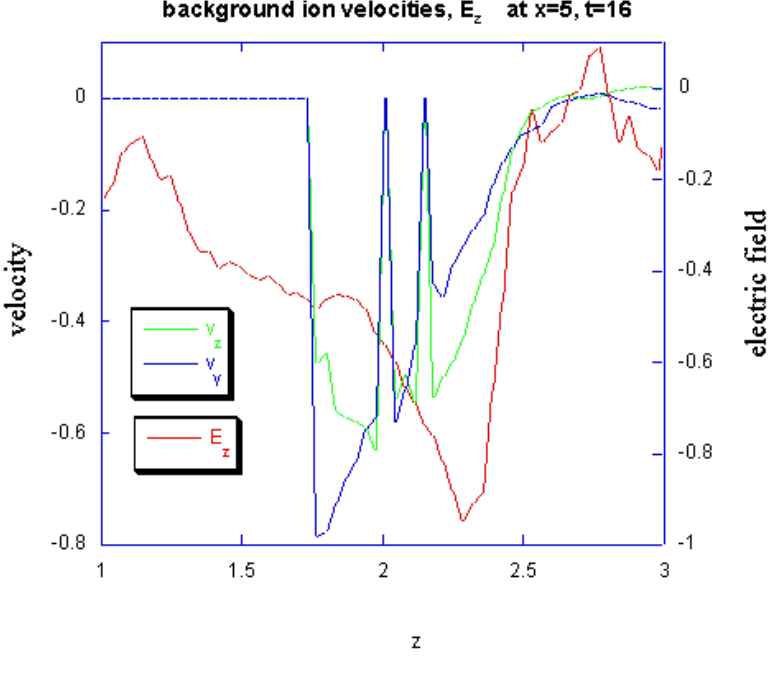
Fig. 8. Background proton velocities at x = 5 and t = 16. Plotted are the y - and z -components of the proton veloc- ity (blue and green, respectively), and the z -component of the electric field